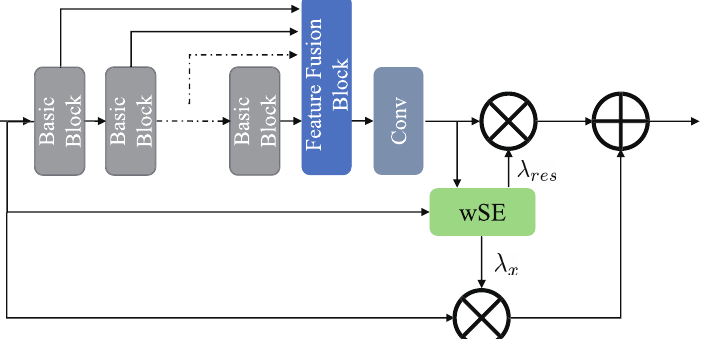
Figure 4. wRU module, the wSE module is used to generate weight values for different